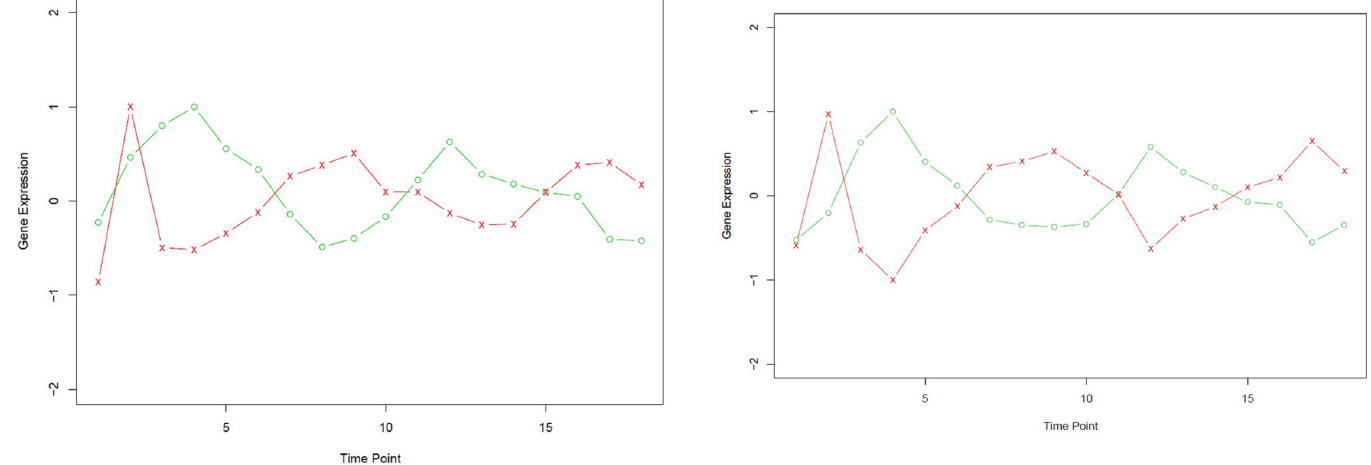
Fig 1. A. Original time-course expression of the gene pair RAD51-HST3 , where the red cross (green circle) denotes expression levels of RAD51 ( HST3 ). B. Kernelized (using polynomial kernel of degree 2) expression of the gene pair RAD51-HST3 .